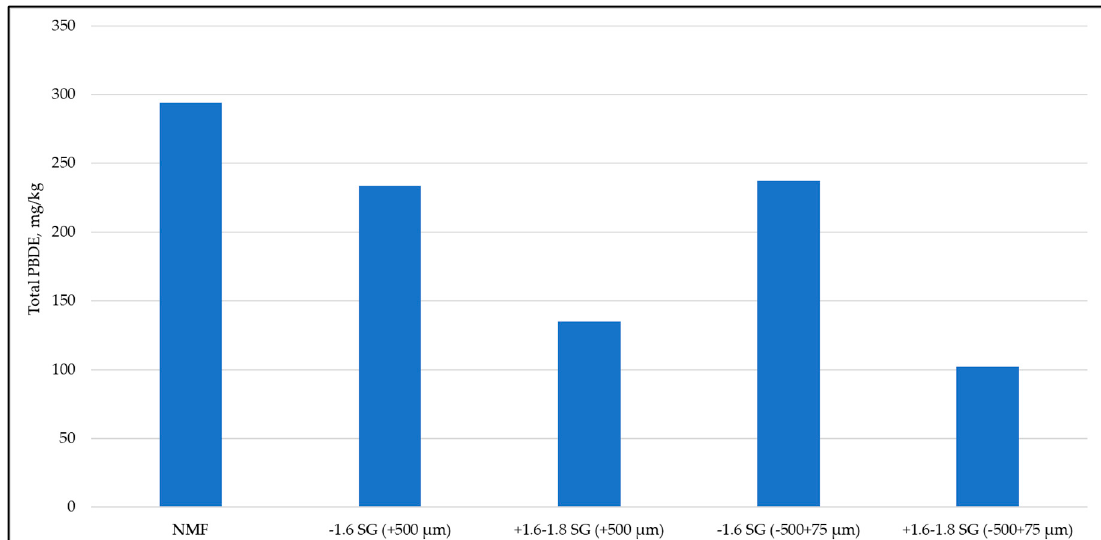
Figure 4. Change in the PBDE concertation in various density fractions.